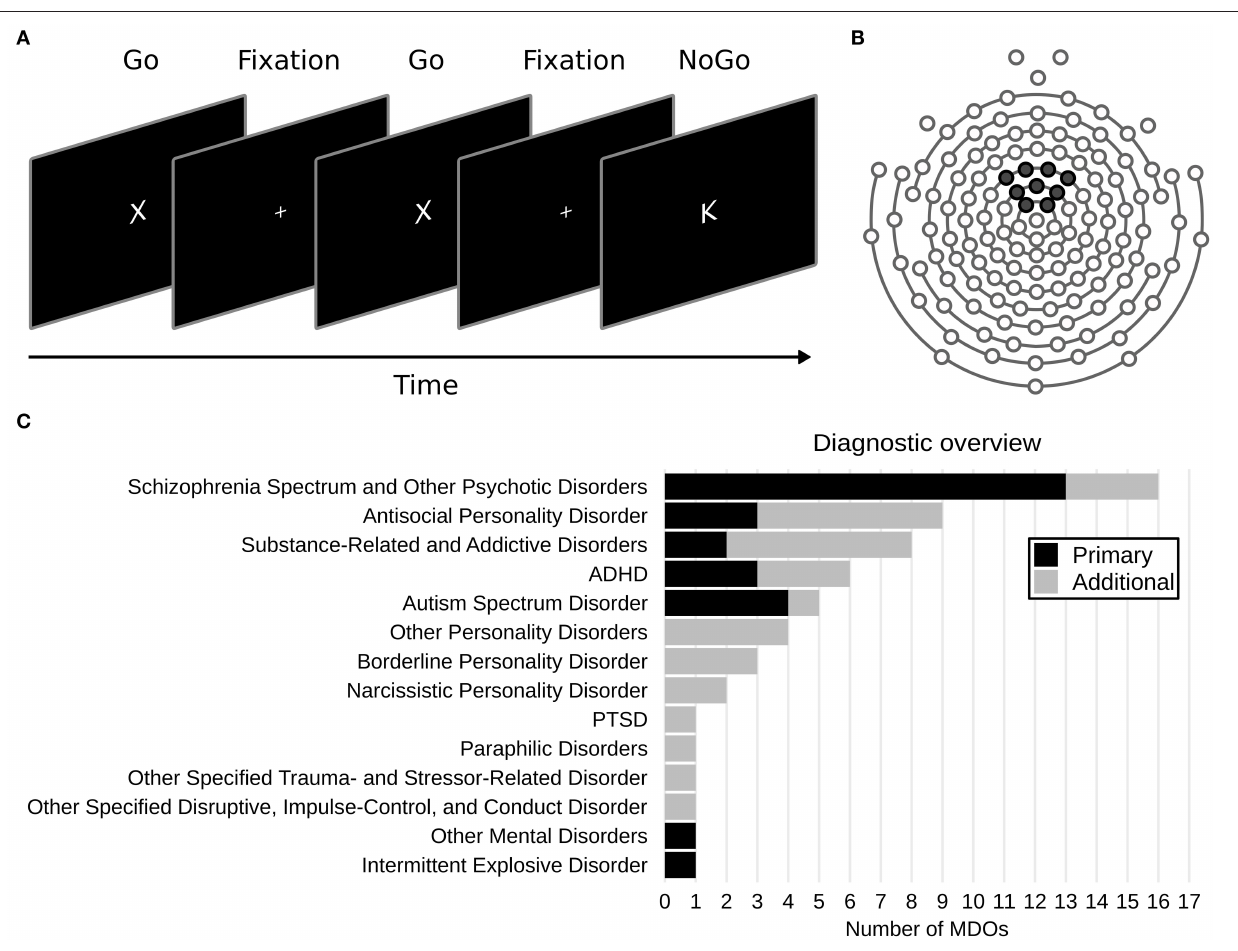
FIGURE 1 | (A) Overview of the Go/NoGo task. (B) Layout of the 128 channel sensor net used. Black markers show the location of the nine electrodes used to create a frontocentral region of interest. (C) Overview of DSM-5 diagnoses in the mentally disordered offenders (MDOs) group.